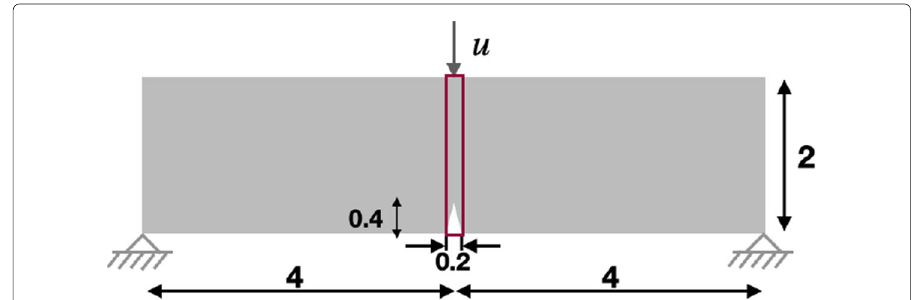
Fig. 9 Geometry, with dimensions in mm, and boundary conditions used in the three-point bending simulations; the refined mesh is in the region marked red